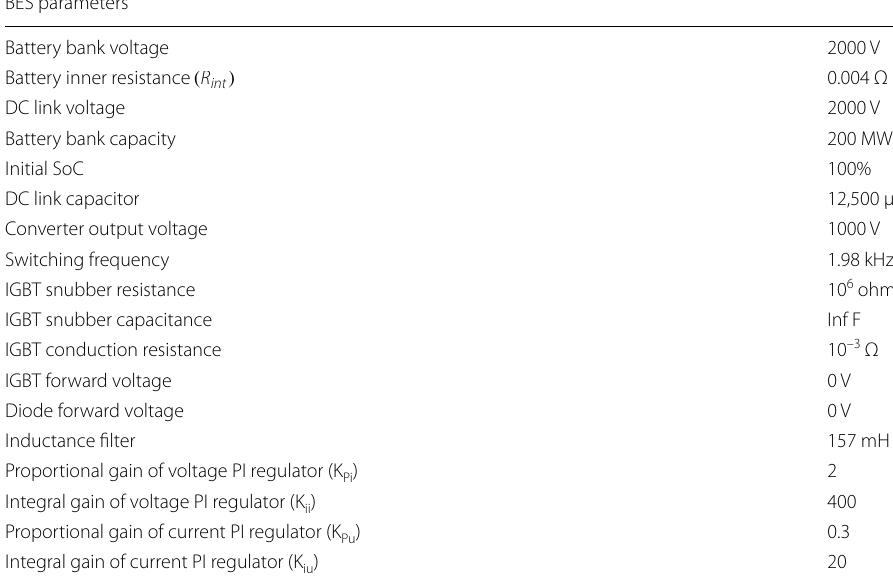
Table 4 Data of the